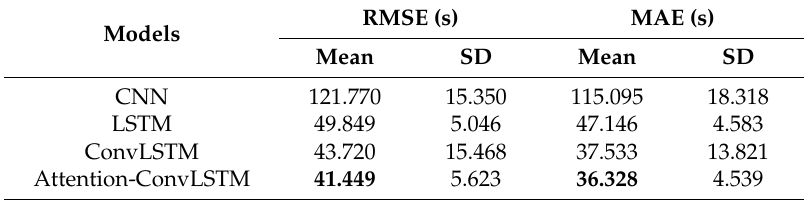
Table 3. Performance comparison of the bus running time prediction models for a stop.